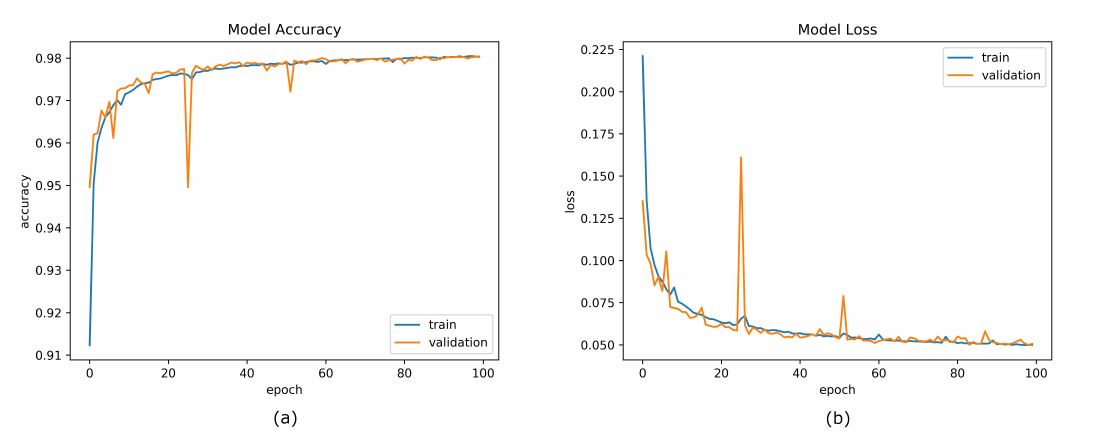
Figure 8. Metrics evolution over training time of our proposed network. ( a ) Epochs vs. Accuracy. ( b ) Epochs vs.